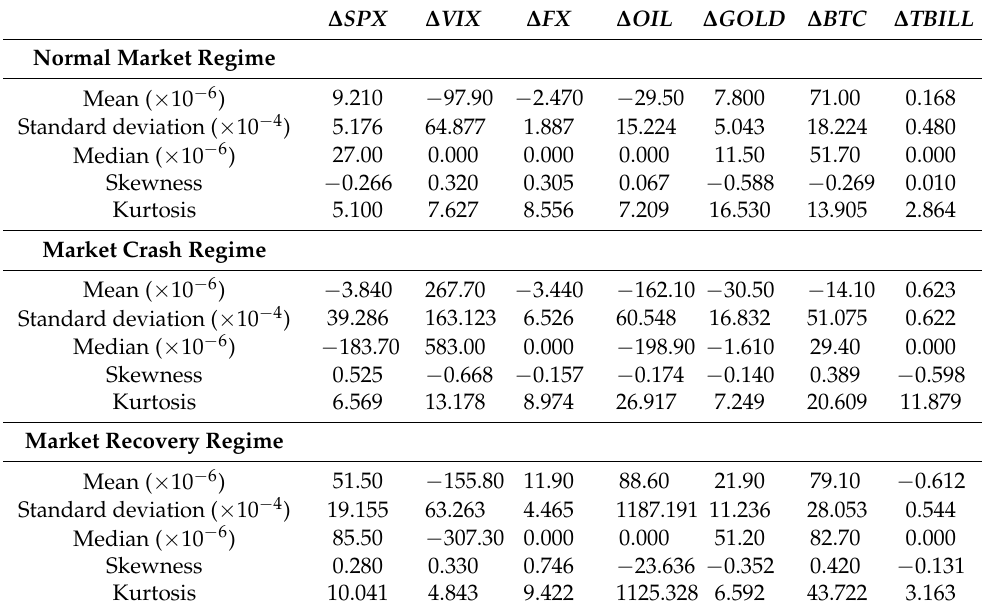
Table 1. Summary